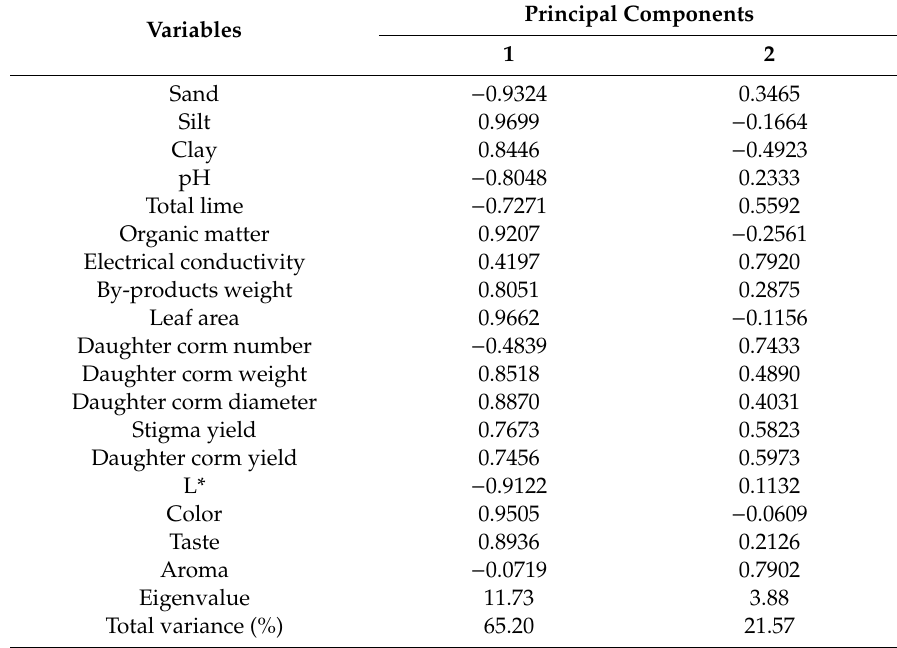
Table 7. Loadings of the significant variables on two first principal components from analysis of morphological, quantitative and qualitative